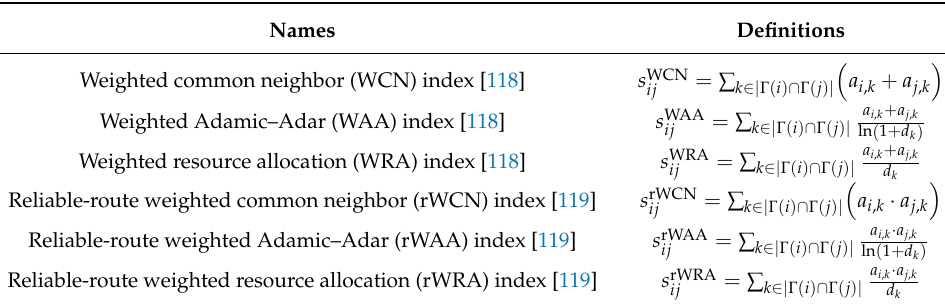
Table 1. Six local similarity measures based on two-hop paths